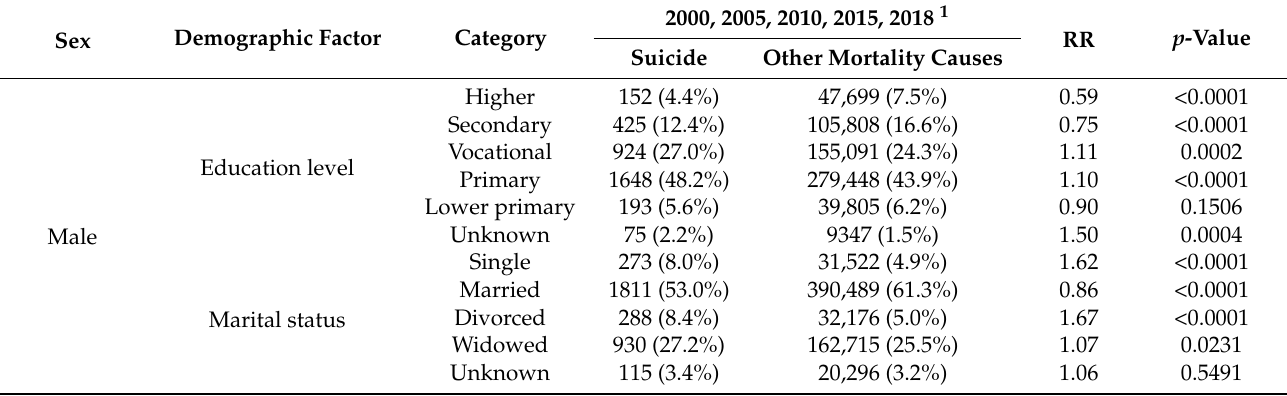
Figure 2. Suicide rates (per 100,000 population) among female adults aged 65 or older by age groups from 2000 to 2018. Source: Polish Central Statistical Office (CSO). Table 2. Proportions and relative risks of female and male adults aged 65 or older who died due to suicide by education and marital